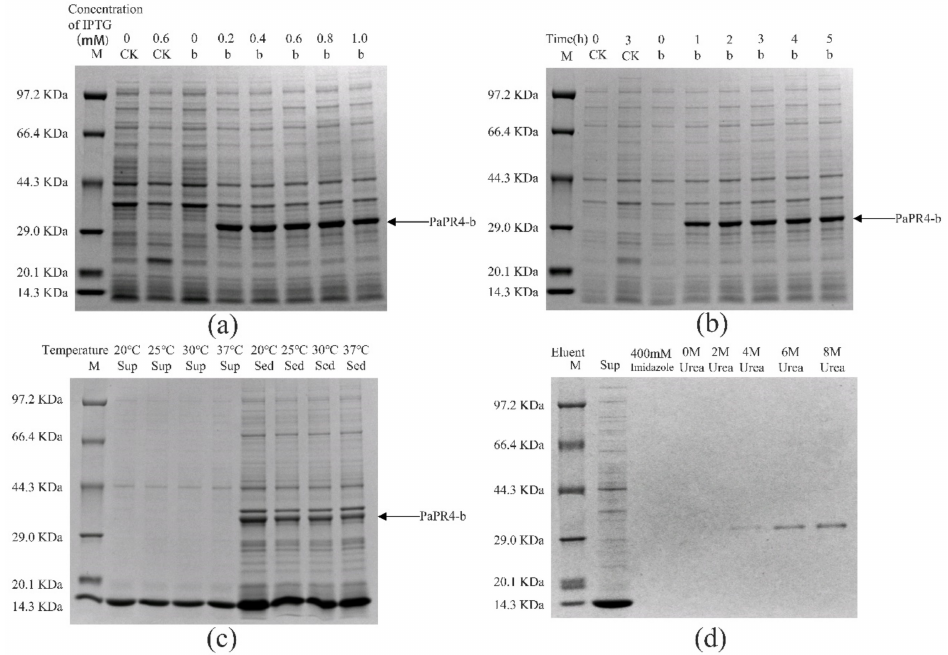
Figure 5. Analysis of the recombinant PaPR4-b protein with SDS-PAGE. M: Protein marker. CK: pET-32a vector expressed in E. coli BL21 (DE3) cells. Sup: supernatant. Sed: sediment. ( a ) The recombinant PaPR4-b protein was induced to express at 0, 0.2, 0.4, 0.6, 0.8 and 1.0 mM concentrations of IPTG. ( b ) Expression levels of the recombinant PaPR4-b protein at 0, 1, 2, 3, 4 and 5 h. ( c ) Induction of expression and detection of solubility of the recombinant PaPR4-b protein at 20 ◦ C, 25 ◦ C, 30 ◦ C and 37 ◦ C. ( d ) Renaturation and purification of the recombinant PaPR4-b